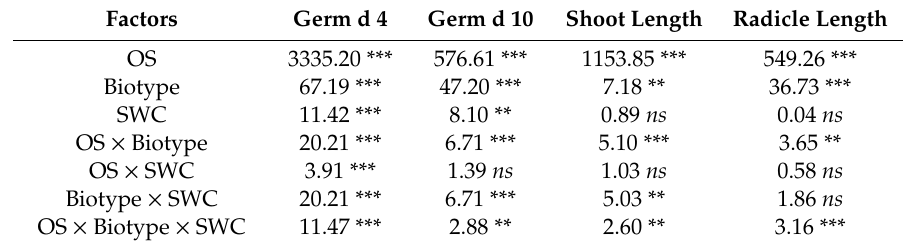
Table 2. ANOVA table with F values and statistical significance of the germination percentage at 4 d (Germ d 4) and 10 d (Germ d 10) after stress imposition, and of radicle and shoot length. OS = osmotic stress (0, − 0.4, − 0.8, − 1.2, − 1.4 and − 1.6 MPa); biotype = winter vs. spring; SWC = seed weight classes,